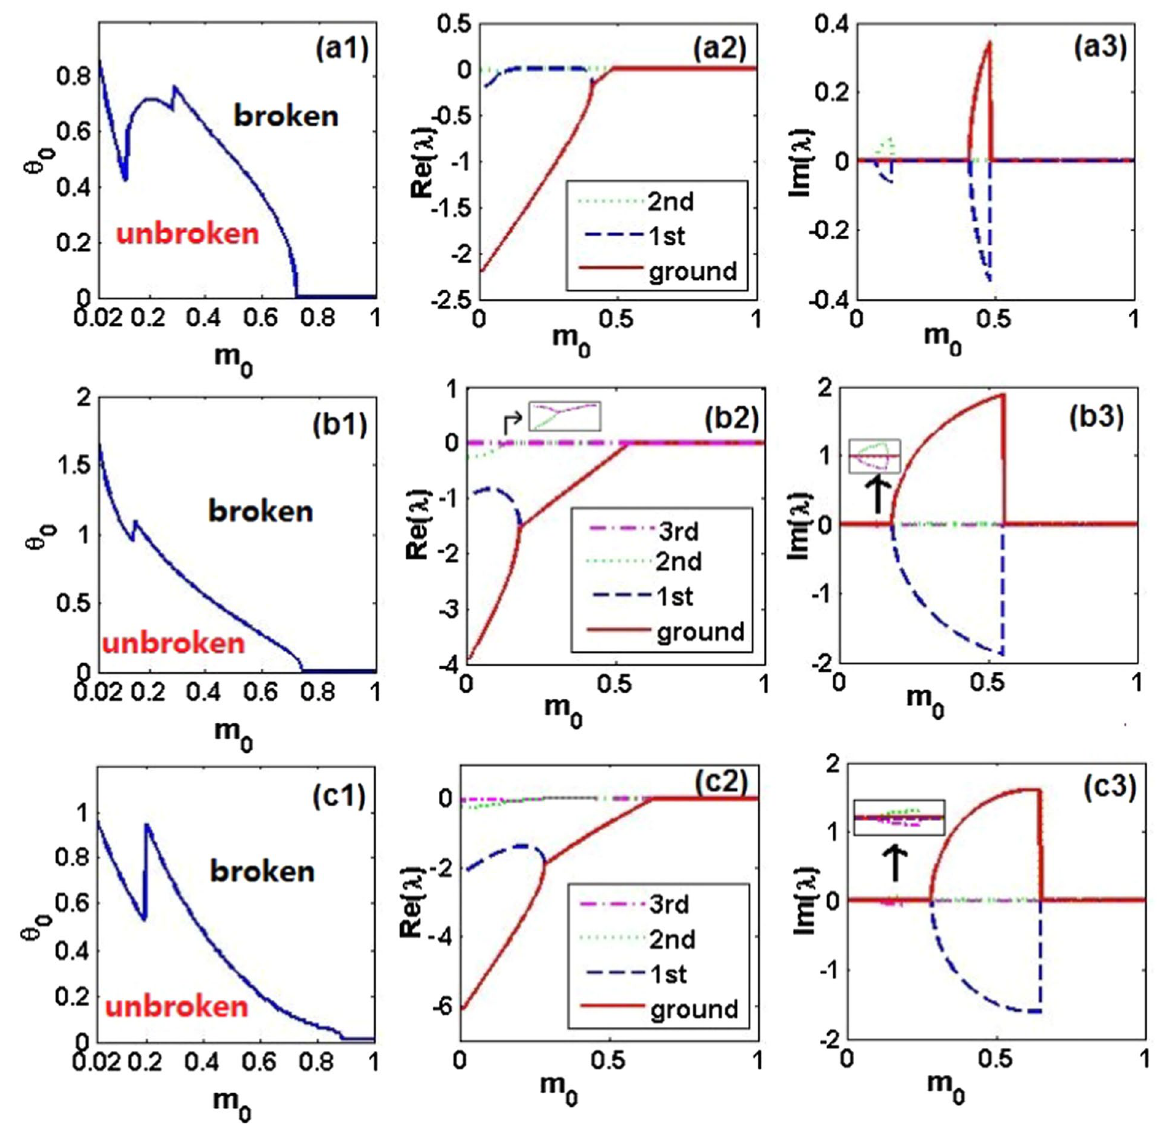
Figure 1. Linear spectrum in PT -symmetric potentials. ( a1 , b1 , c1 ) The PT -symmetry of states produced by linear eigenvalue problem (5), with the position-dependent diffraction coefficient (2) and generalized PT -symmetric Scarf-II potentials (3) and (4), is unbroken/broken in the domains below/above the solid blue curves. The results are displayed for α = 1, 2, 3, respectively. ( a2 , b2 , c2 ) Real and ( a3 , b3 , c3 ) imaginary parts of first several eigenvalues λ as a function of m 0 for θ 0 = 0.6, 1, 0.7, respectively. The insets in ( b2 ) and ( b3 , c3 ) show, severally, the separation and coalescence of the real and imaginary parts of the second and third energy